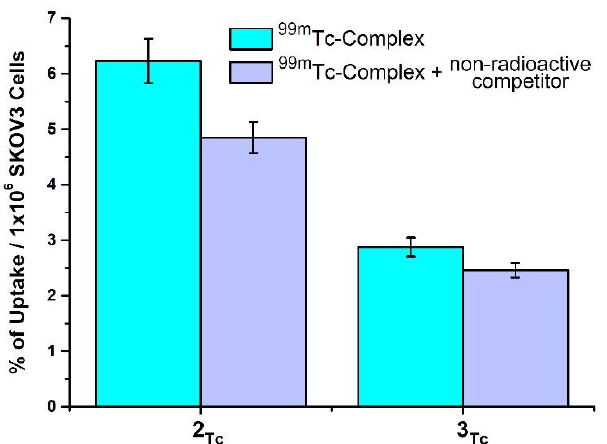
Figure 6. Results of binding assay for 2 Tc and 3 Tc carried out on SKOV3 ovarian cancer cells.